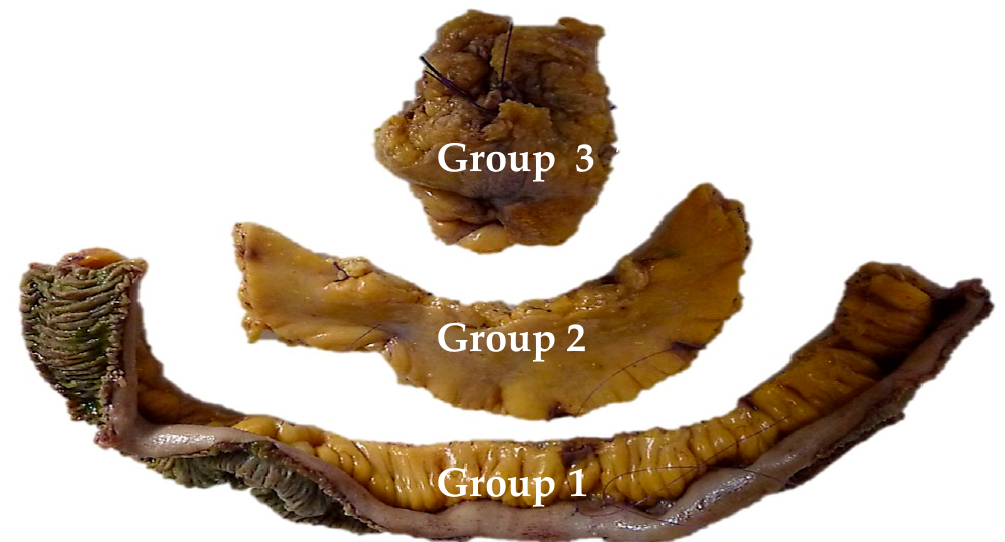
Figure 3. Showing the three nodal groups whose resection is recommended. Figure issued from Pasquer, A., Walter, T., Rousset, P., et al. Lymphadenectomy during Small Bowel Neuroendocrine Tumor Surgery: The Concept of Skip Metastases. Ann Surg Oncol . 2016; 23 (Suppl 5): 804–808. Doi: 10.1245/s10434-016-5574-8. Reproduced with permission of Springer nature [23].